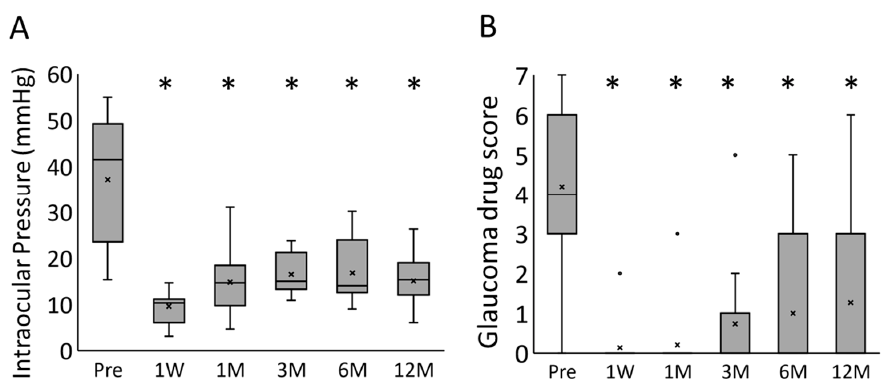
Figure 2. The box-and-whisker plots for the time course changes of the ( A ) intraocular pressure and ( B ) glaucoma drug score. * p < 0.0001 (mixed-effect model); Pre, preoperative; 1W, 1